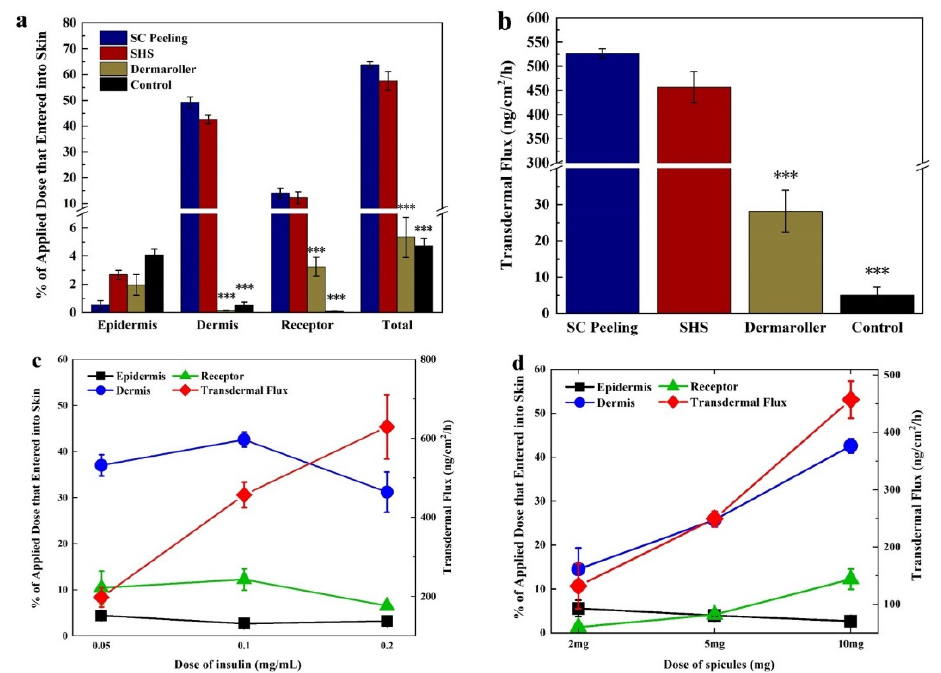
Figure 2. The correlation between the skin permeability enhancement ratio ( ER ) and the aspect ratio of spicules ( L/D ). Both linear and power-law fittings are shown as purple and black dash lines, with an R 2 of 0.69 and 0.82, respectively.